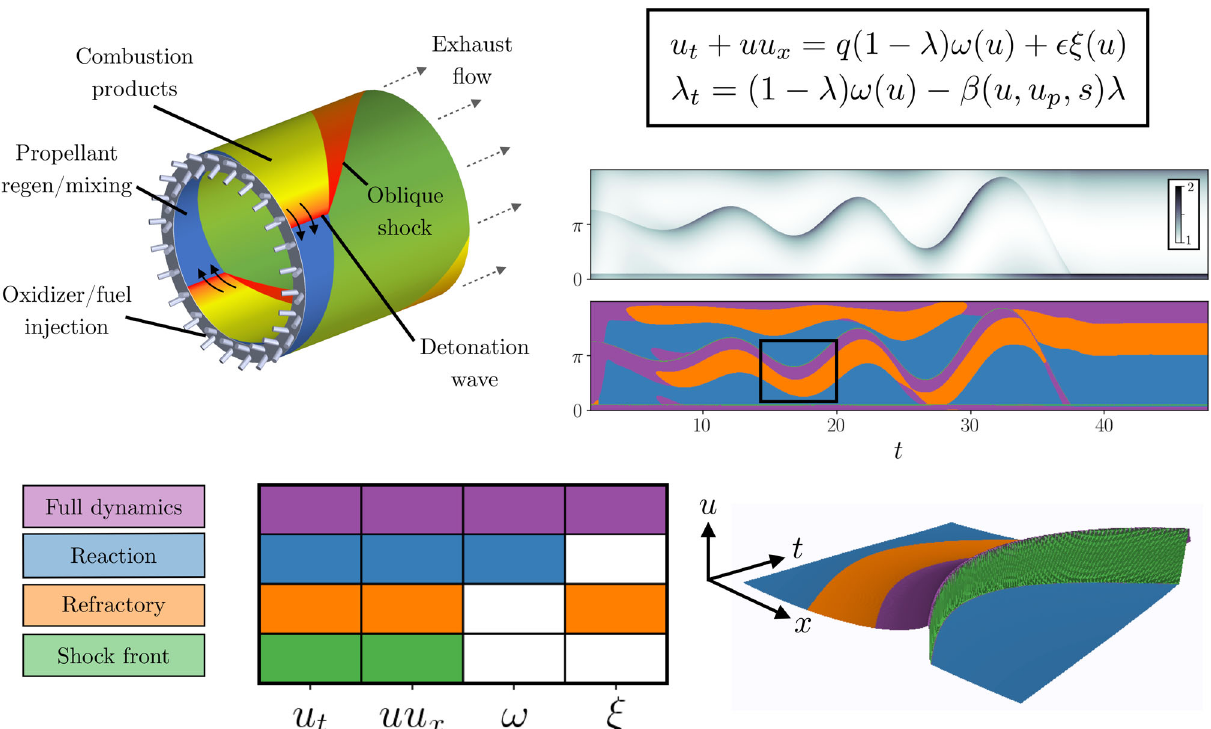
Fig. 6 Model of combustion dynamics in a rotating detonation engine. The dynamics on the thin shock front are determined by the canonical Burgers balance (green), followed by activation of the gain and loss terms (purple). Following the combustion front, the balance transitions to the refractory exhaust-dominated period (orange). The rest of the domain is characterized by a combination of the Burgers dynamics with background energy input. All plots are visualized with the scalar state variable u ( x , t